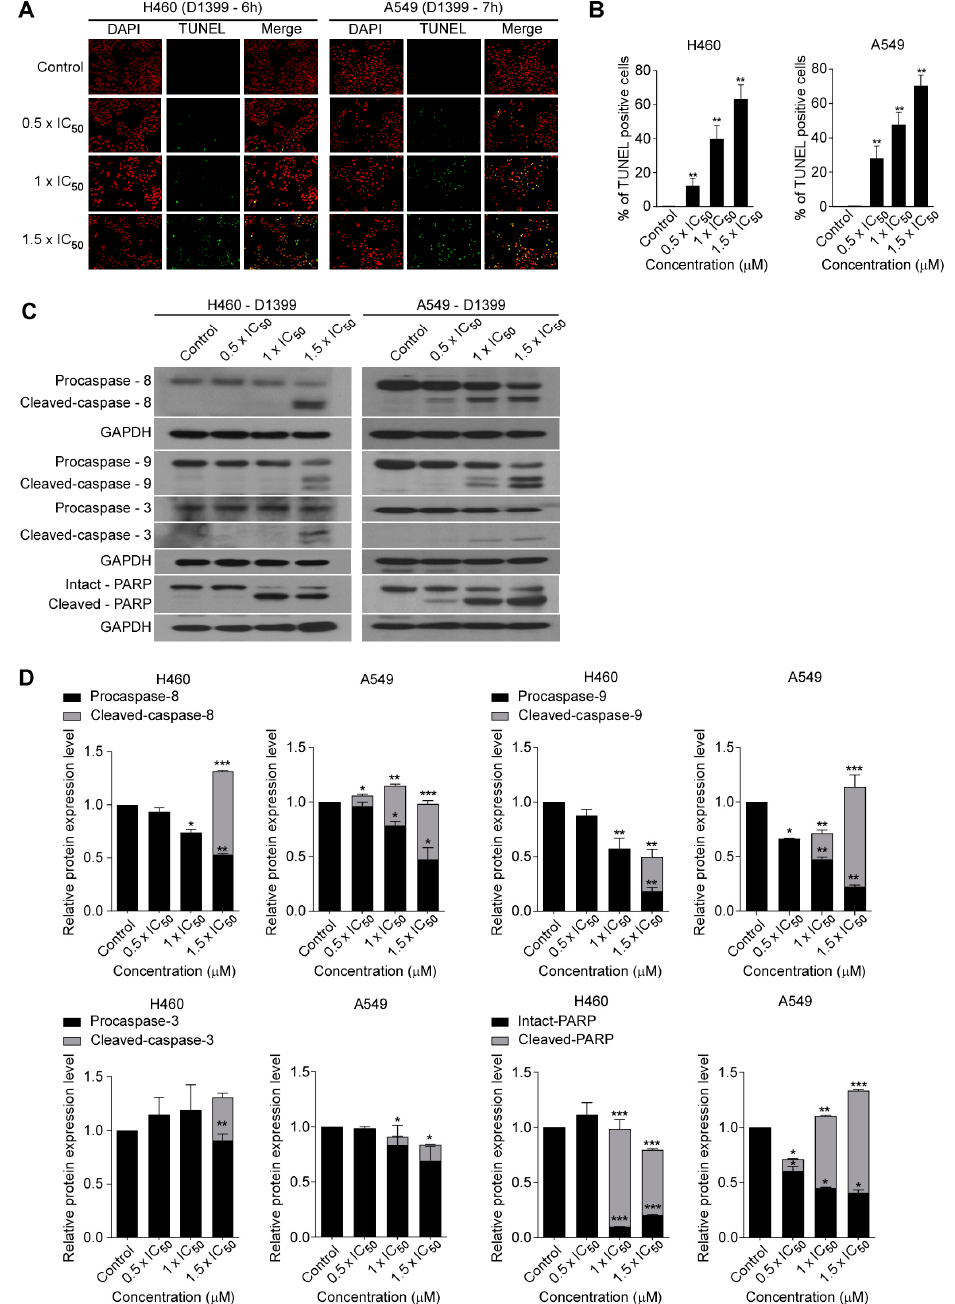
Figure 3. D1399-induced apoptosis in lung cancer cells. ( A ) H460 and A549 cells were respectively treated with various concentrations of D1399 for 6 h and 7 h and labelled with fluorescein-12-dUTP (green) and DAPI (red); ( B ) Apoptotic index as examined by counting and calculating the percentages of TUNEL-positive cells in 10 fields; ( C ) Influence of D1399 on the expression of apoptosis regulatory proteins. Western blotting analysis of caspases and PARP in H460 and A549 cells after D1399 treatment at the indicated concentrations and using antibodies against caspase-8, 9, and 3 and the poly adenosine diphosphate-ribose polymerase (PARP) is shown. The glyceraldehyde-3-phosphate dehydrogenase GAPDH is used as control; ( D ) Quantification shows the influence of D1399 on the expression of apoptosis regulatory proteins, including caspase-8, 9, and 3 and PARP. All protein levels were normalized to the GAPDH protein level. Data for the quantitative assessment of the proteins are expressed as means ± SD. * p < 0.05, ** p < 0.01, *** p < 0.001.